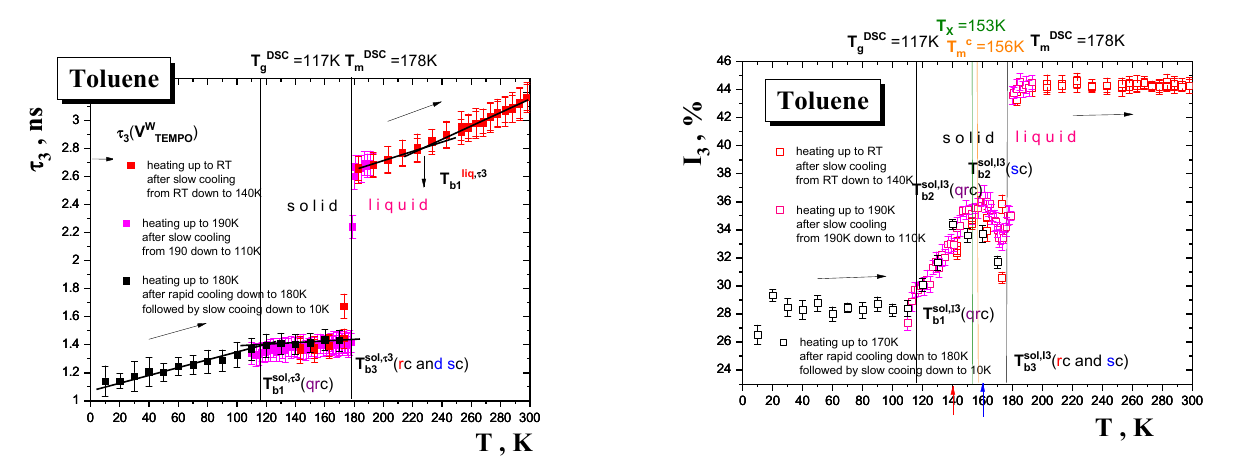
with the observed thermal events.